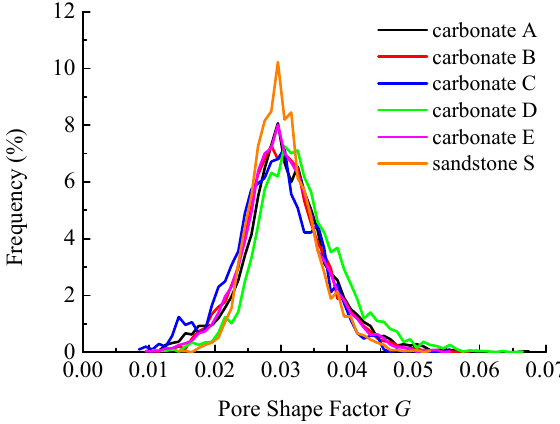
Figure 15. Distribution of pore shape factor in REV2s of test samples.